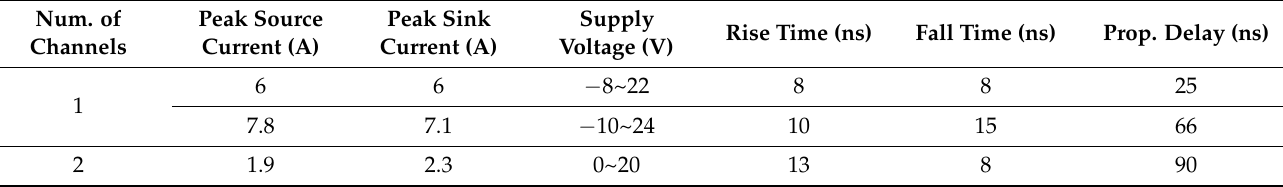
Table 30. Commercial SiC MOSFET drivers by On Semiconductor.